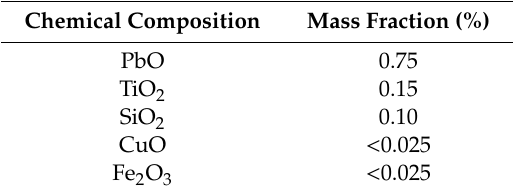
Table 3. Chemical composition of the sealing solder (mass fraction